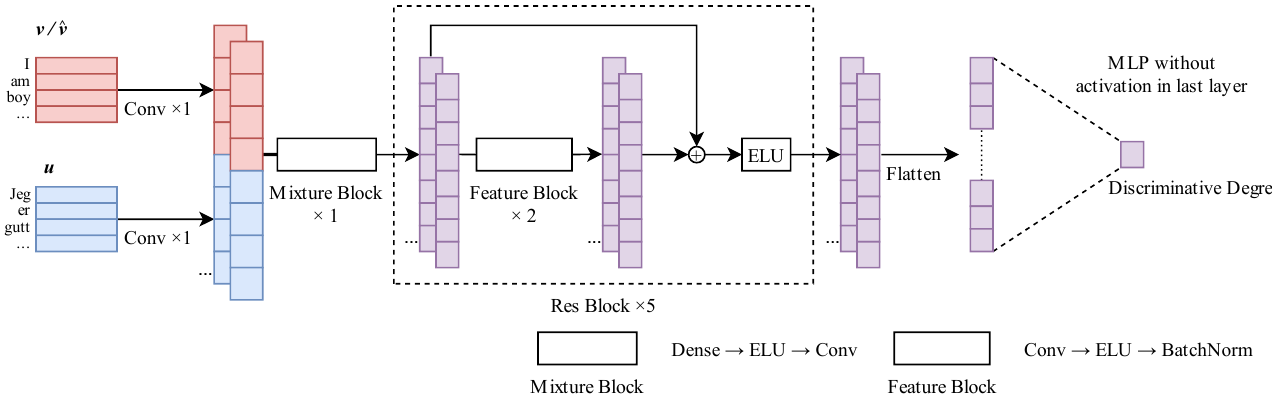
Figure 2. Structure of Discriminator 𝐷 . Red and blue represent the (𝑢, 𝑣̂) and (𝑢, 𝑣) pairs, respectively, and purple denotes the mixture hidden states.